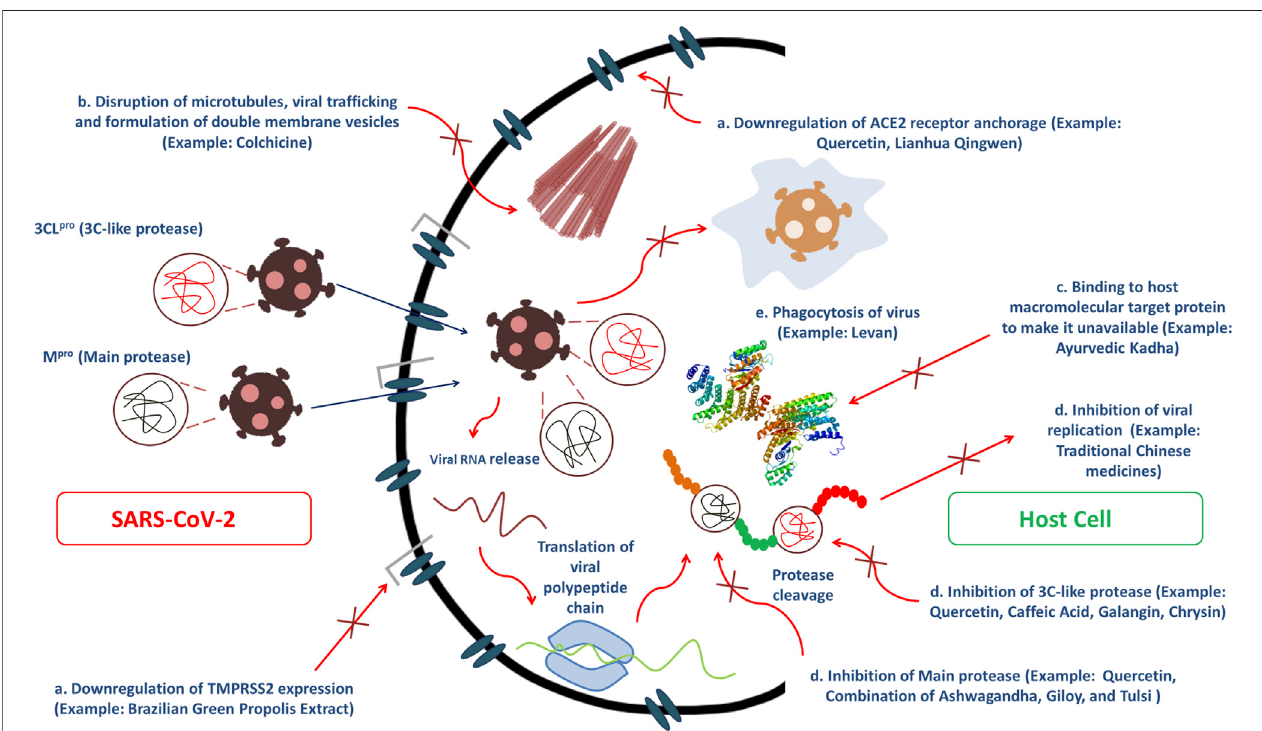
FIGURE2| Severalmodesofbioactivephytoconstituentsand traditional herbal medicines toexertanti-COVID-19ef fi cacyincluding (A) inhibition ofmainprotease and 3C-like protease, (B) Disruption of microtubules, viral traf fi cking and formulation of double membrane vesicles, (C) Binding af fi nity toward host macromolecular targetproteintomakeitunavailableand (D)